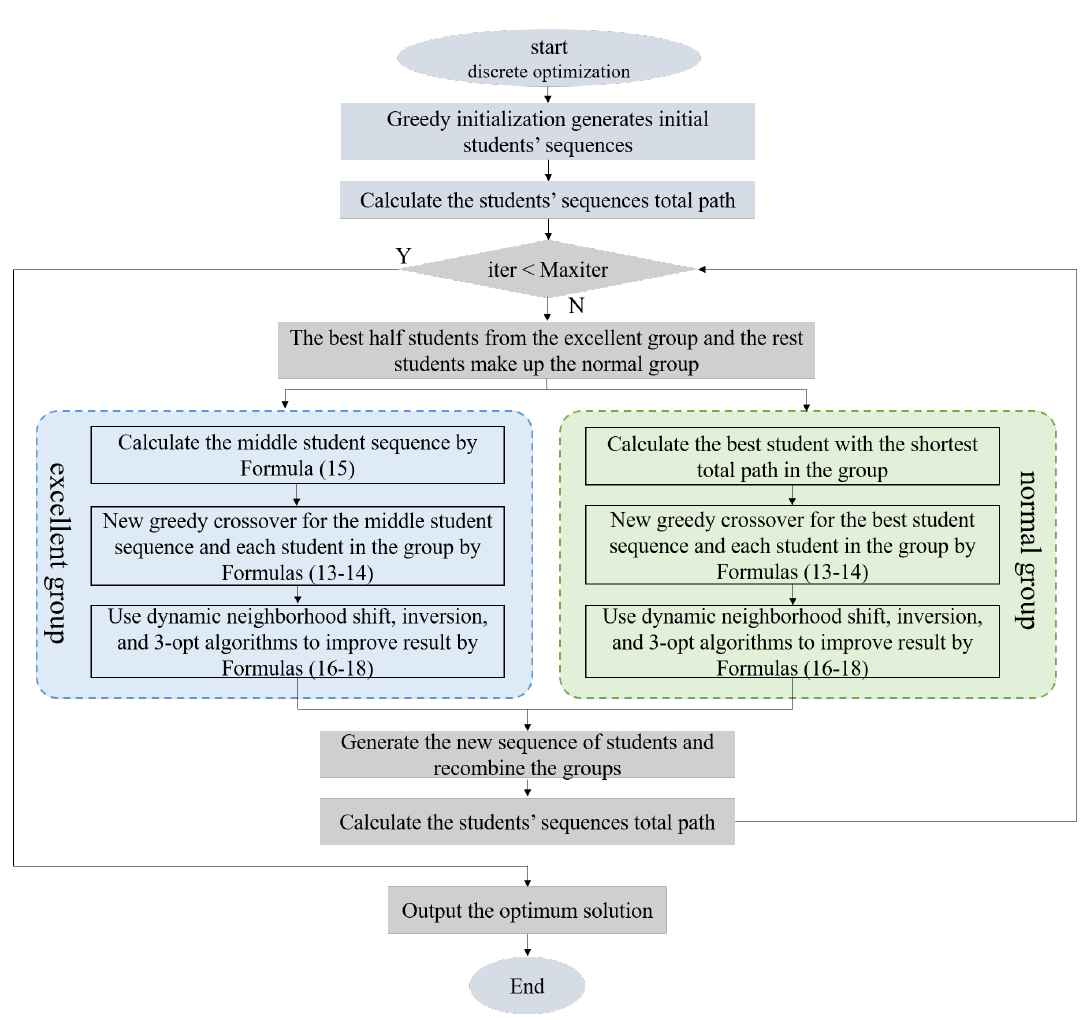
Figure 3. Flowchart of discrete group teaching optimization